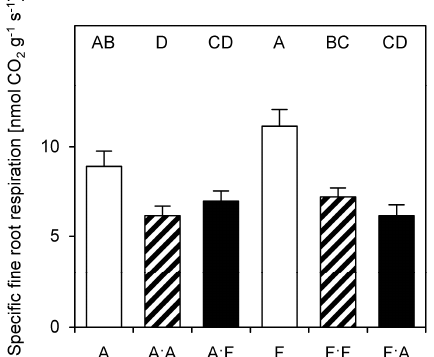
Figure 4. Specific fine root respiration (RR S ; 20 °C) of Acer pseudoplatanus (A) and Fagus sylvatica (F) under three different competition treatments in nutrient-rich soil patches. A, Acer root grown in isolation (no competition); A:A, Acer root grown in competition with another Acer root; A:F, Acer grown in competition with Fagus ; F, Fagus grown in isolation; F:F, Fagus grown in competition with Fagus ; F:A, Fagus grown in competition with Acer (mean + SE, n = 15–49; see Supplementary Table S5 for GLM statistics).